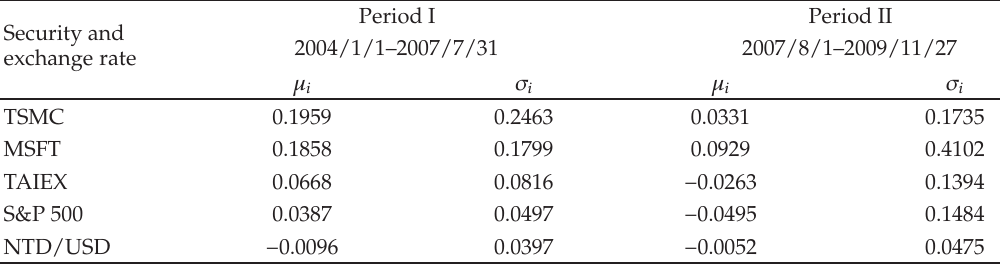
Table 2: Parameter estimation of dynamic processes of asset returns and exchange rate returns in various